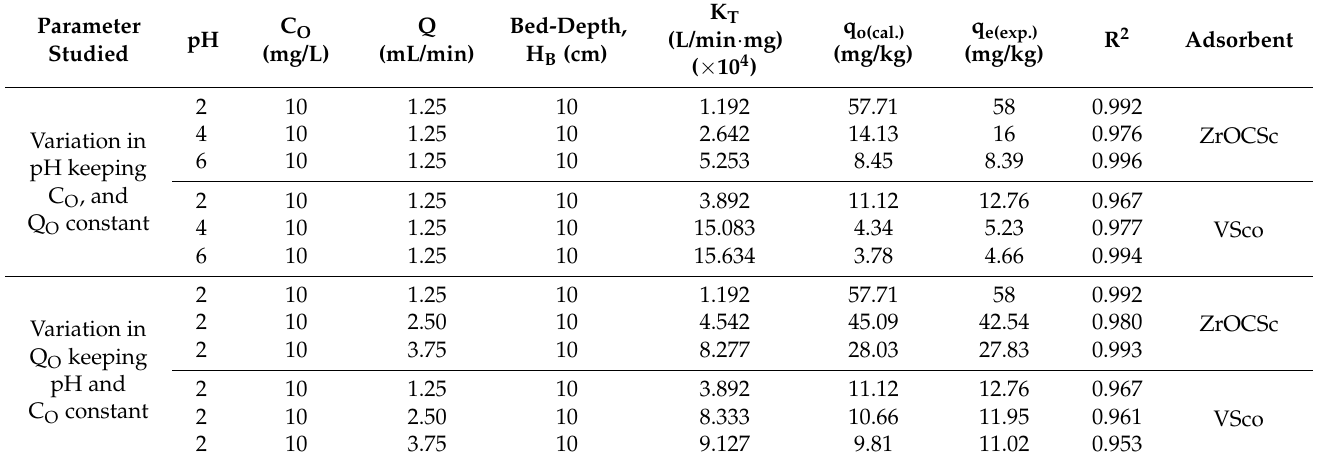
Table 3. Thomas model parameter values for the defluoridation by VSco and ZrOCSc.